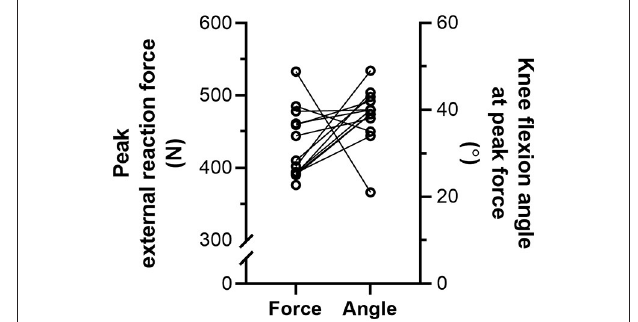
FIGURE 4 | Individual left-sided peak external reaction forces ( N = 14) and knee flexion angles ( n = 13) at peak force during the Nordic hamstring exercise (NHE) trial with the highest peak force. Solid lines link the same participant, and descriptive statistics are reported in the Results section.